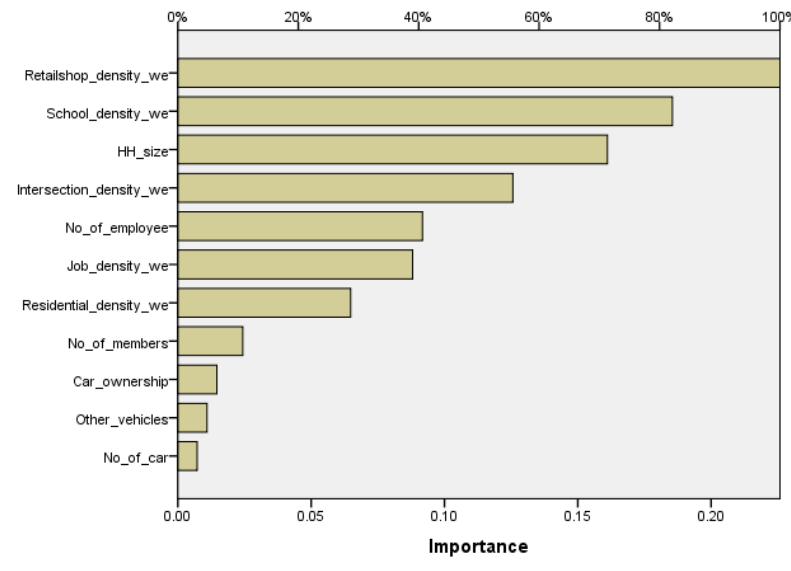
Figure 15. Normalized importance.